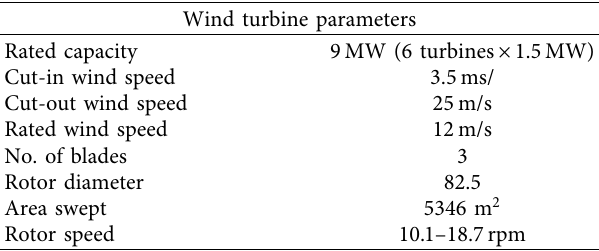
Table 6: Wind turbine parameters [18].